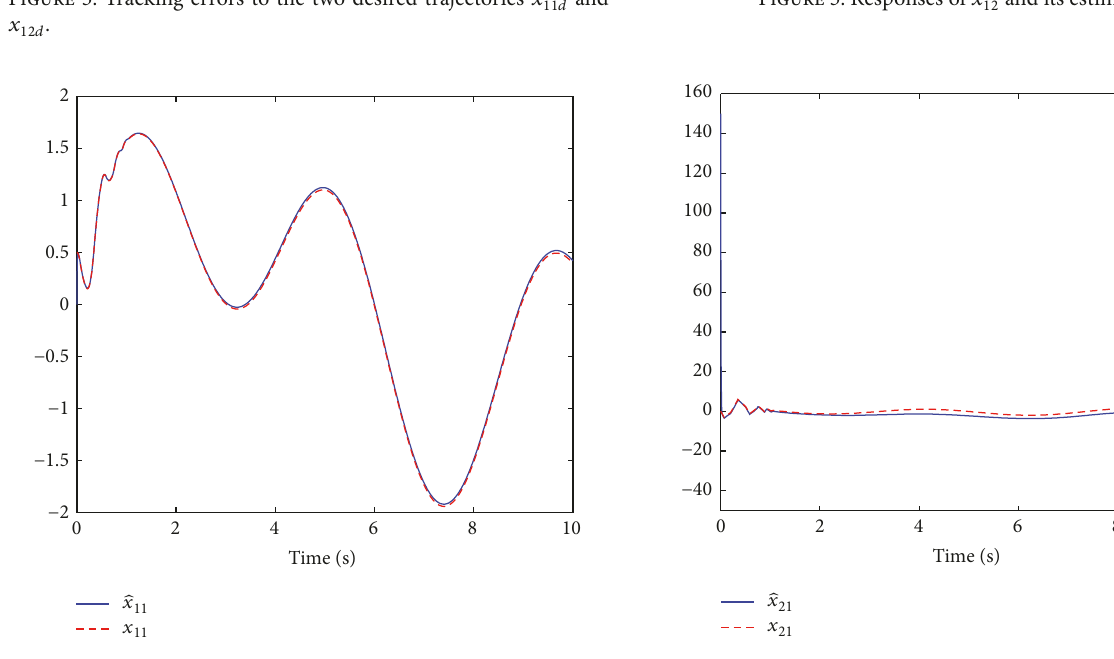
Figure 6: Responses of 𝑥 21 and its